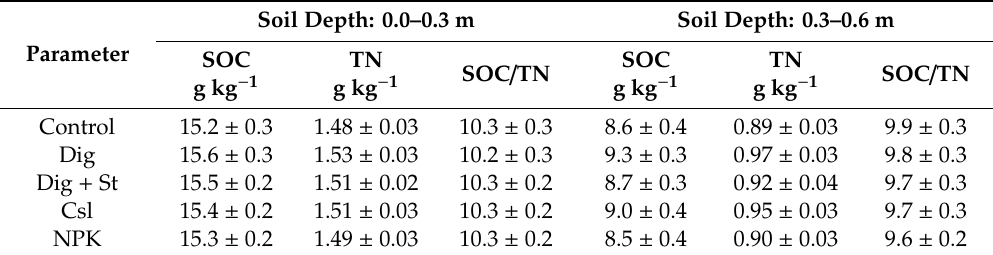
Table 4. Soil organic carbon (SOC), total nitrogen (NT), and SOC / TN ratio as a result of di ff erent crop residue management and application of manure, organic, and mineral fertilizers (mean for 4 years ± standard error of the